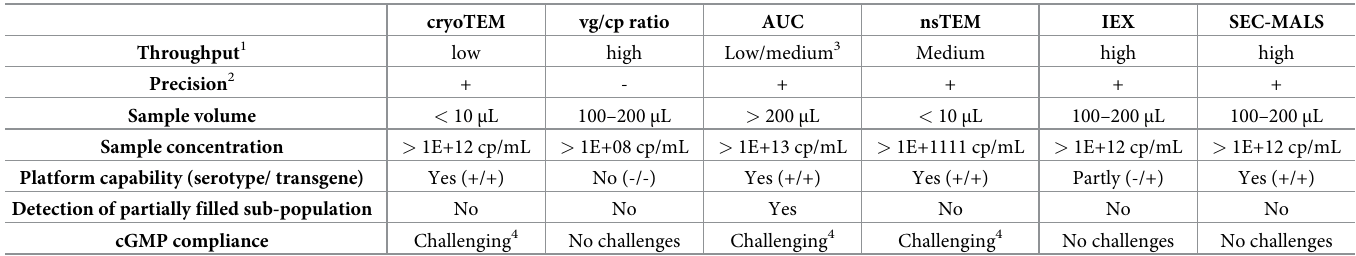
Table 1. Comparison of orthogonal techniques commonly used to quantitate the relative contents of full and empty AAV